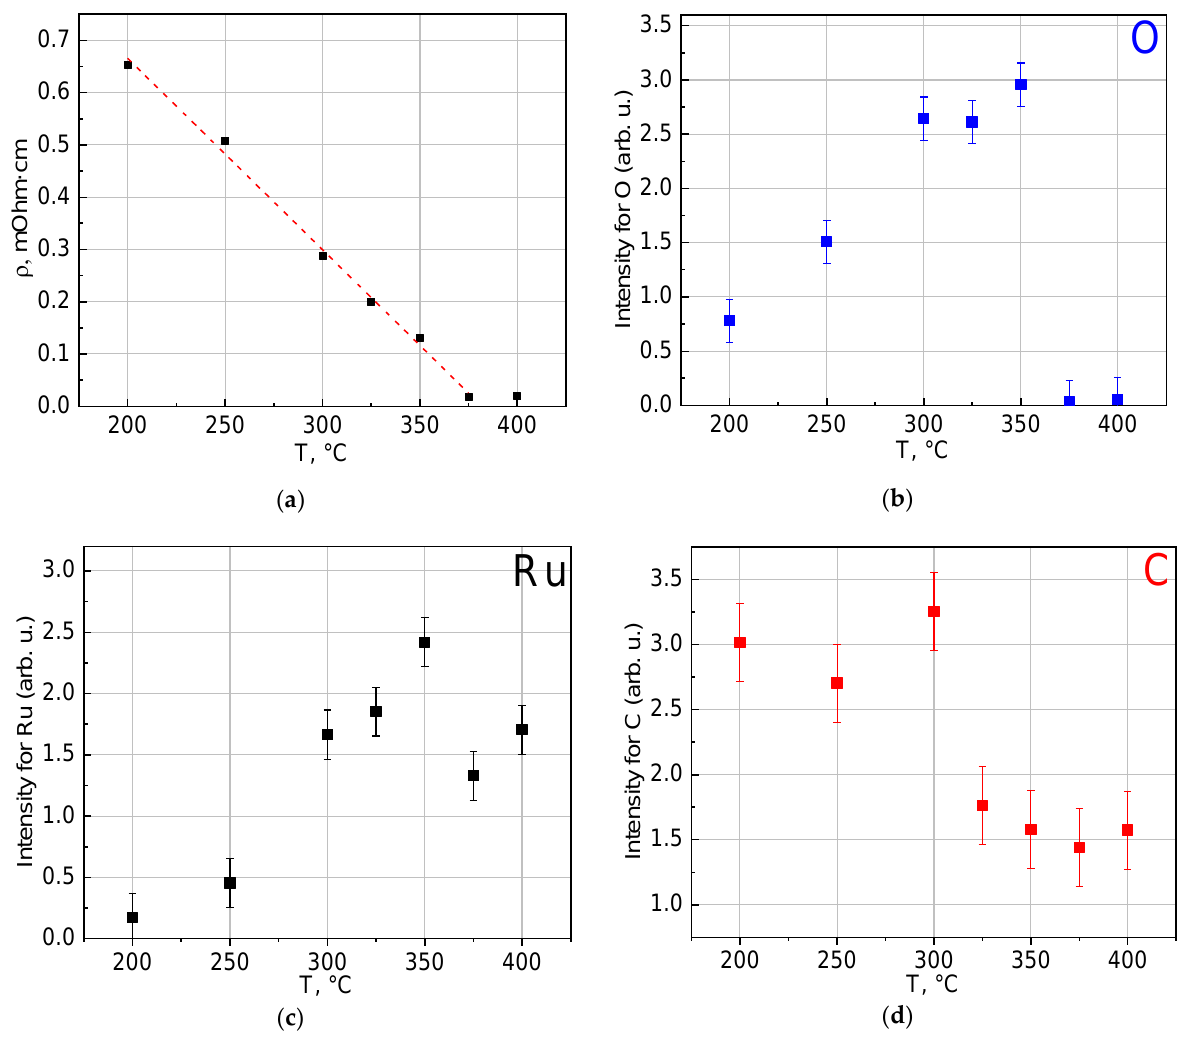
Figure 1. ( a ) Resistivity vs. deposition temperature; ( b – d ) secondary ion mass spectrometry (SIMS) yield of 18 O, 102 Ru, and carbon-containing ions in the coatings deposited at different temperatures, respectively.